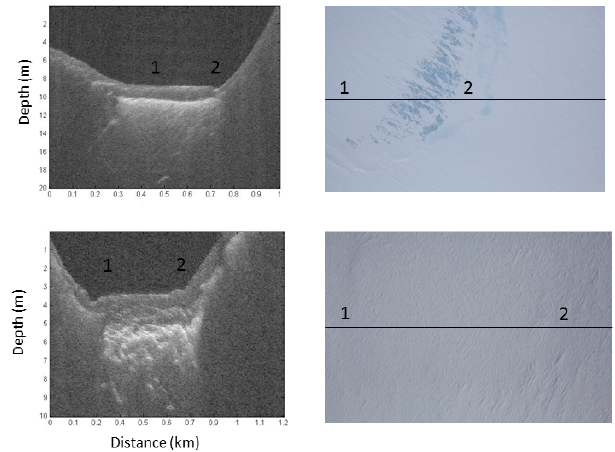
Figure 4. Snow Radar echograms of buried lakes (left) with DMS imagery of the GrIS surface (right) from (top) a rare buried lake in northwest Greenland ( ∼ 45km inland from the terminus of Steen- strup Glacier) with a surface expression showing darker blue where there is buried liquid water and a more turquoise, lighter blue where the lake is frozen through and from (bottom) a typical buried lake in western Greenland ( ∼ 60km inland from the terminus of Jakob- shavn Isbræ) showing surface sastrugi and no detectable lake sur- face expression.